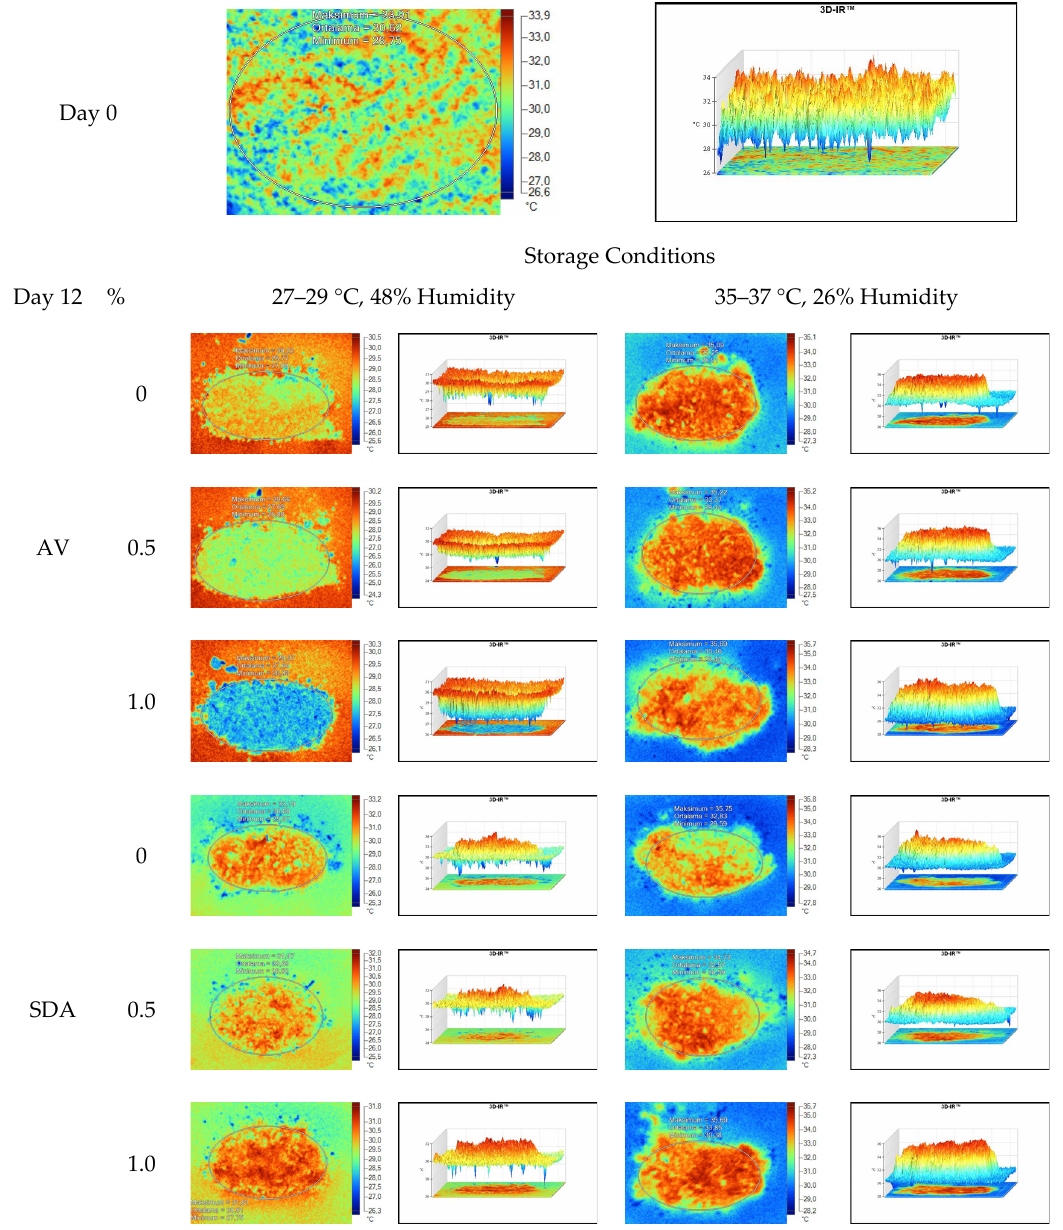
Figure 8. Thermal camera imaging samples of aerobic stability on day 12 (Ambient temperature = 22 °C; AV: Apple vinegar; SDA: Sodium diacetate).